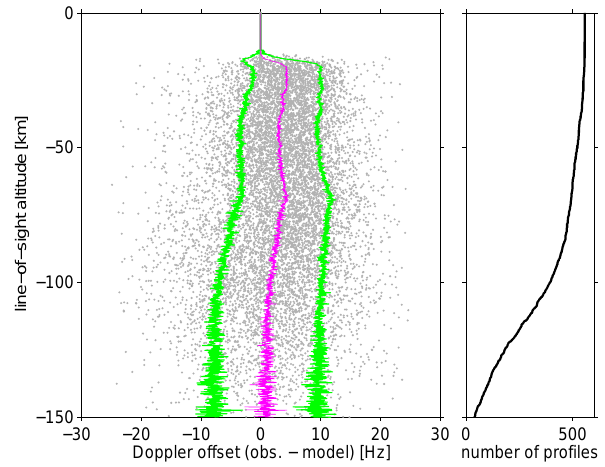
Fig. 6. Left: Difference between total and NCO frequency as a function of line-of-sight altitude. The mean and standard deviation are plotted in pink and green, respectively; the individual data points (for clarity only 2% of the data points are shown) are marked in grey. Right: number of observation samples as a function of line- of-sight altitude. For details see